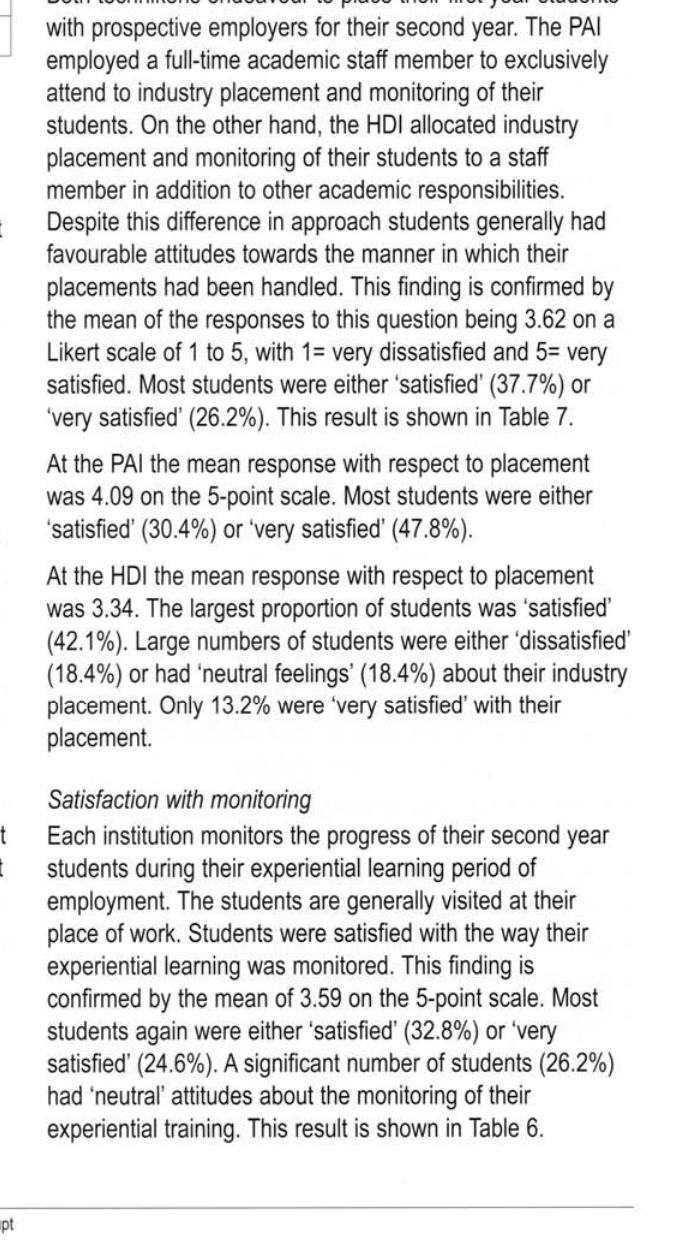
Table 6: Academic or practical nature of course A smaller proportion of students at the HDI (34.1 %) than at the PAl (41.4%) felt that the course was too academic and less practical. A larger proportion of students at the HDI (54.5%) than at the PAl (46.6%) felt that the course was not too